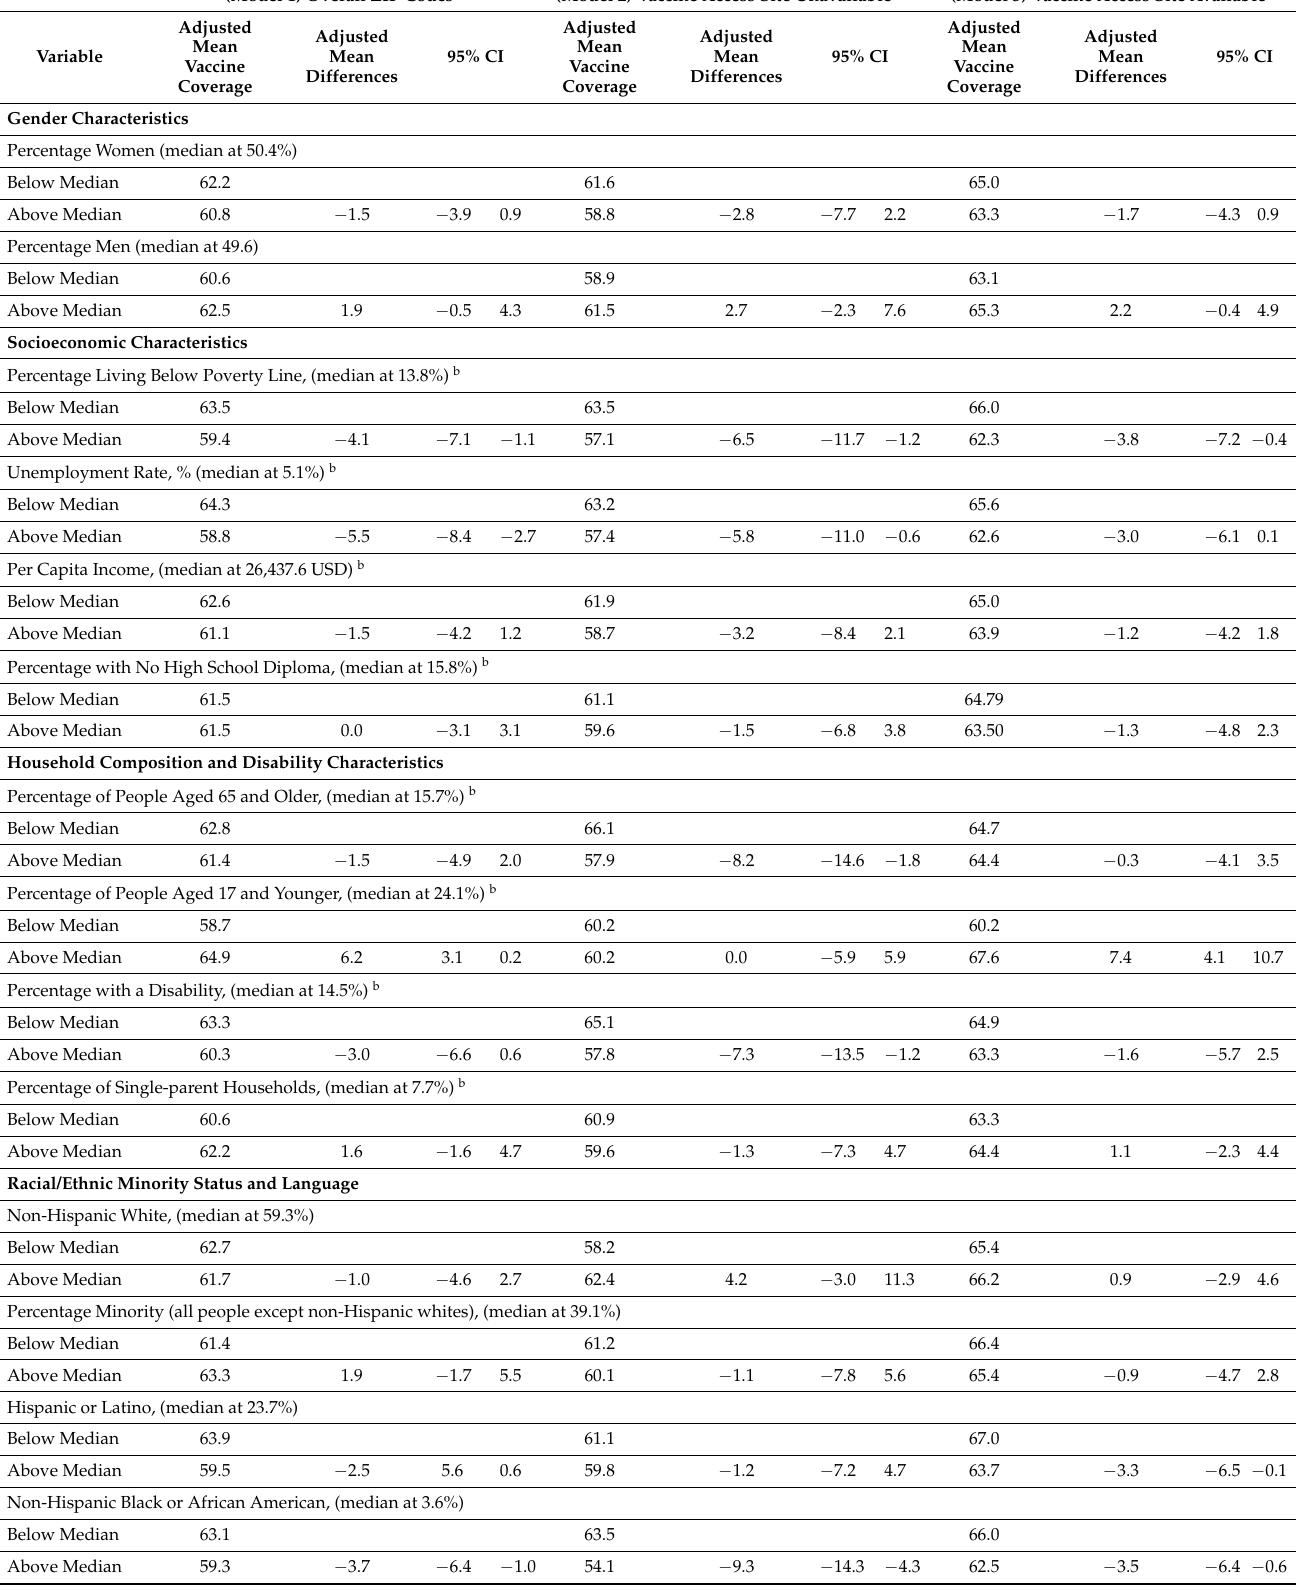
Table 3. The differences in COVID-19 vaccine coverage between most vulnerable (above median) and least vulnerable (below median) ZIP codes by designated COVID-19 vaccine access site availability a